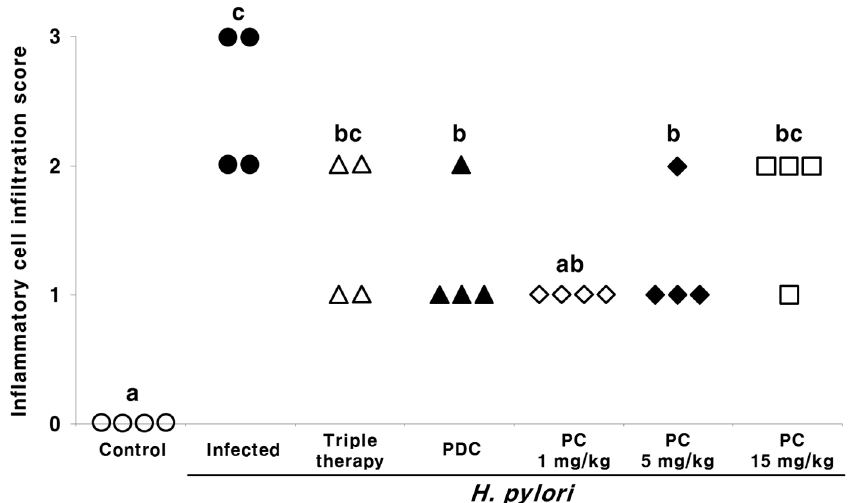
Figure 4. Effect of 3-pentylcatechol (PC) treatment on the histology of gastric tissue from H. pylori -infected mice (hematoxylin and eosin staining). Inflammatory cell infiltration was graded from 0 to 3: 0, normal; 1, mild; 2, moderate; 3, marked. ○ , inflammatory cell infiltration score of control group; ● , inflammatory cell infiltration score of H. pylori -infected group; Δ , inflammatory cell infiltration score of H. pylori + triple therapy-treated group; ▲ , inflammatory cell infiltration score of H. pylori + 3-pentadecylcatechol (PDC)-treated group; ◊ , inflammatory cell infiltration score of H. pylori + 1 mg/kg of PC-treated group; ♦ , inflammatory cell infiltration score of H. pylori + 5 mg/kg of PC-treated group; □ , inflammatory cell infiltration score of H. pylori + 15 mg/kg of PC-treated group. Different letters (a, b, and c) indicate a significant difference ( p < 0.05), ascertained via the Tukey–Kramer test.